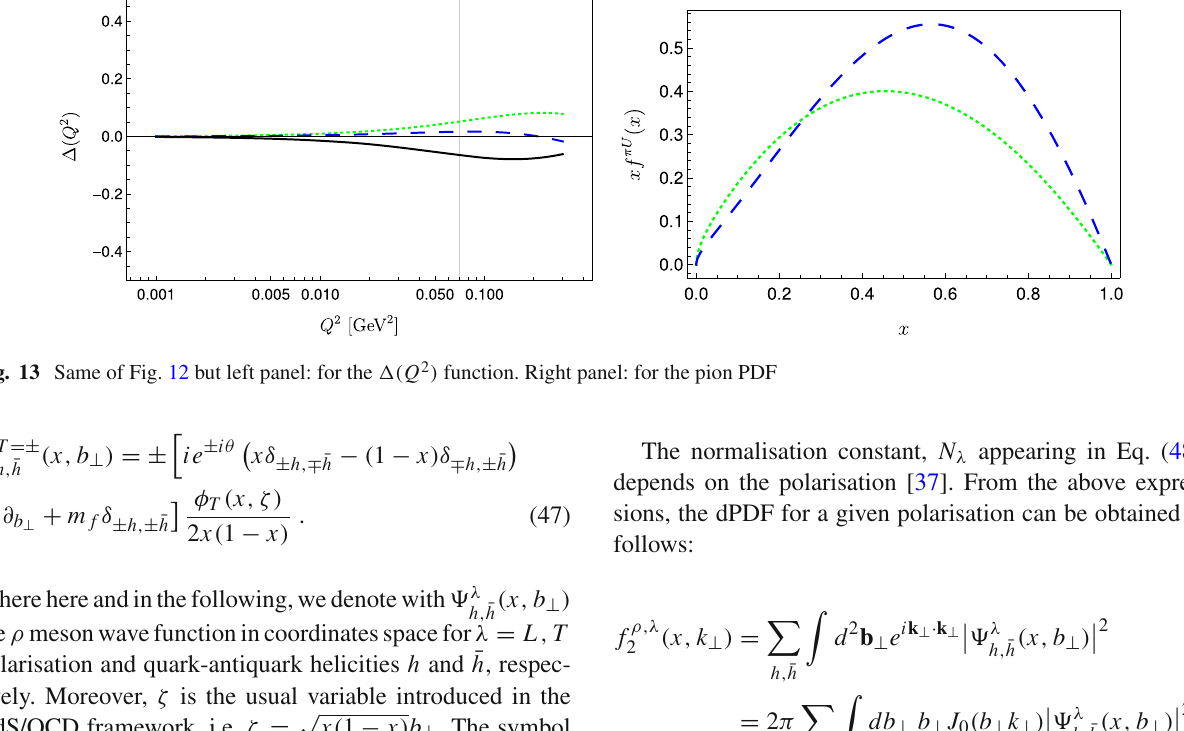
sents the result for the standard values of the parameters a , λ and γ , see Sect. 5.6.2 for details. Right panel: same of the left panel for the quantity F